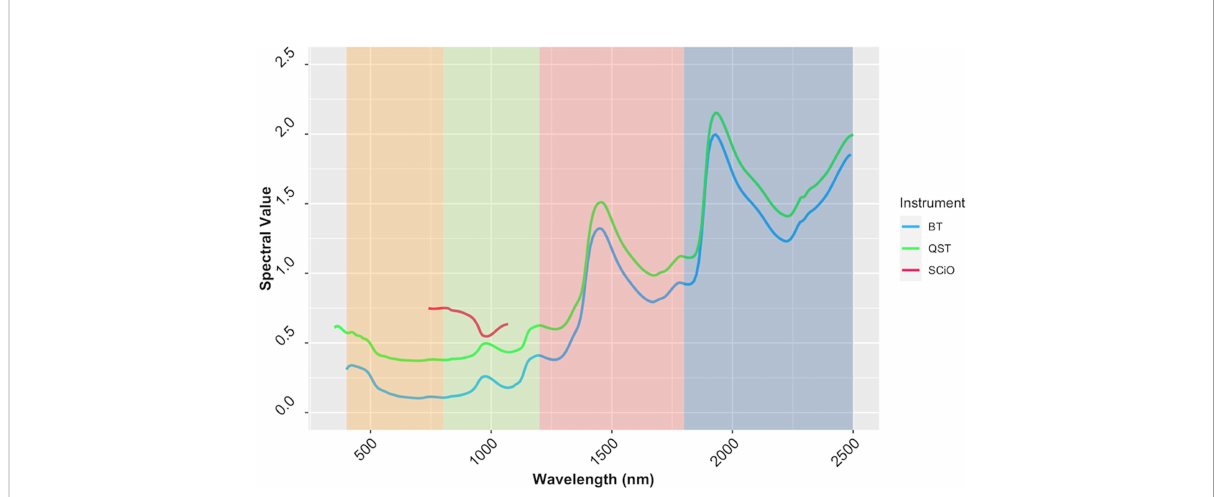
FIGURE 7 The average spectrum of the cassava accessions obtained using ASD QualitySpec ® Trek (QST), Benchtop FOSS XDS Rapid Content ™ Analyzer NIR spectrometer (BT) and pocket-sized SCiO ™ (SCiO). The various NIRS regions are highlighted on the background, yellow (visible; 400 − 800 nm), green (region1; 800 − 1200 nm), pink (region2; 1200 − 1800 nm), and blue (Region 3; 1800 − 2500